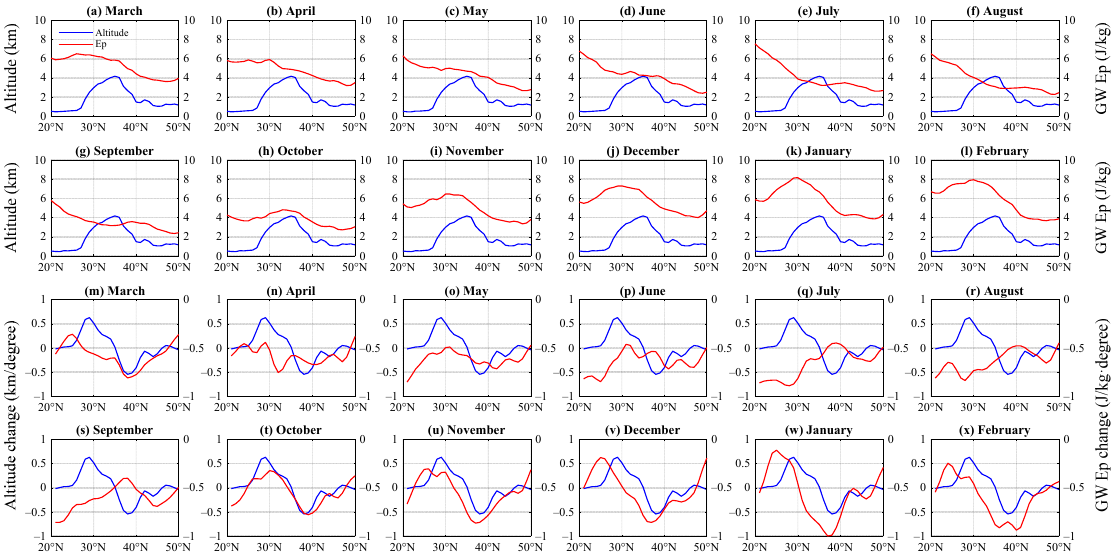
Figure 8. The zonal change and zonal change rate of the monthly mean GW Ep and the elevation from August 2006 to September 2020. Latitude from 20 to 50 ◦ N, longitude from 68 to 105 ◦ E. The red line represents the 18~20 km GW Ep and the blue line represents the elevation.